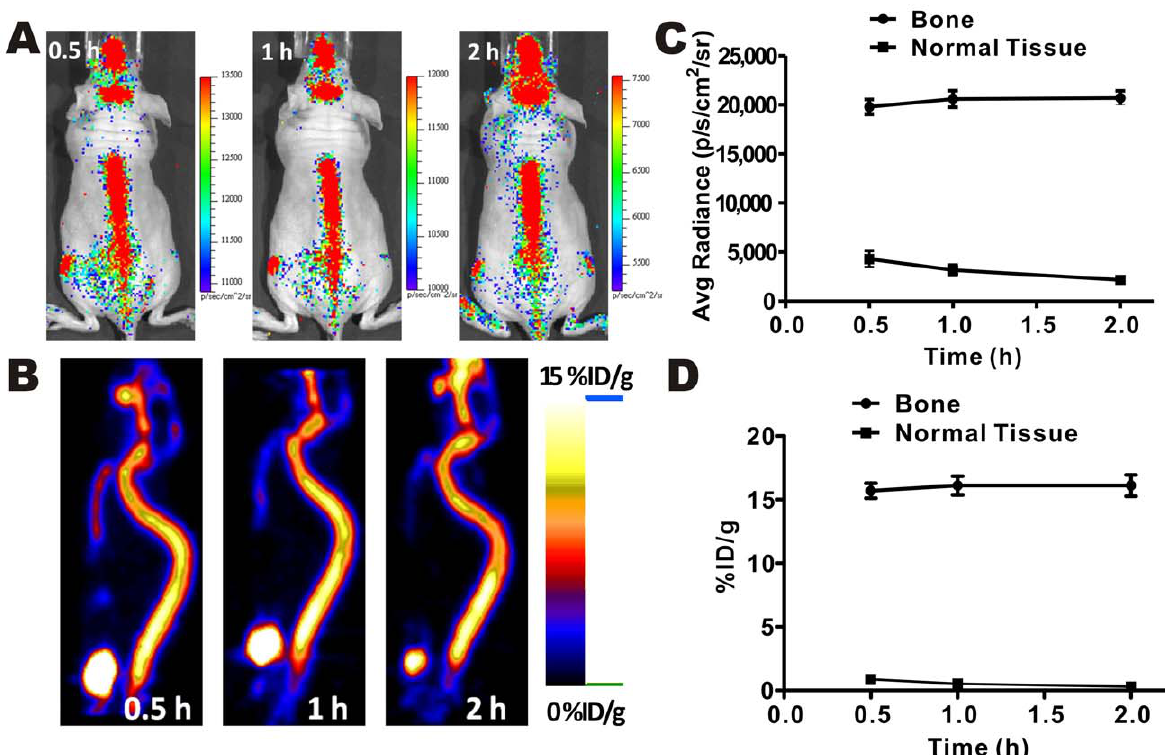
Figure 4. Dual modality Na 18 F imaging. Radioactive OI ( A ) and microPET imaging ( B ) of Na18F at 0.5, 1, 2 h after i.v. injection. Quantitative analysis of radioactive OI ( C ) and microPET ( D )